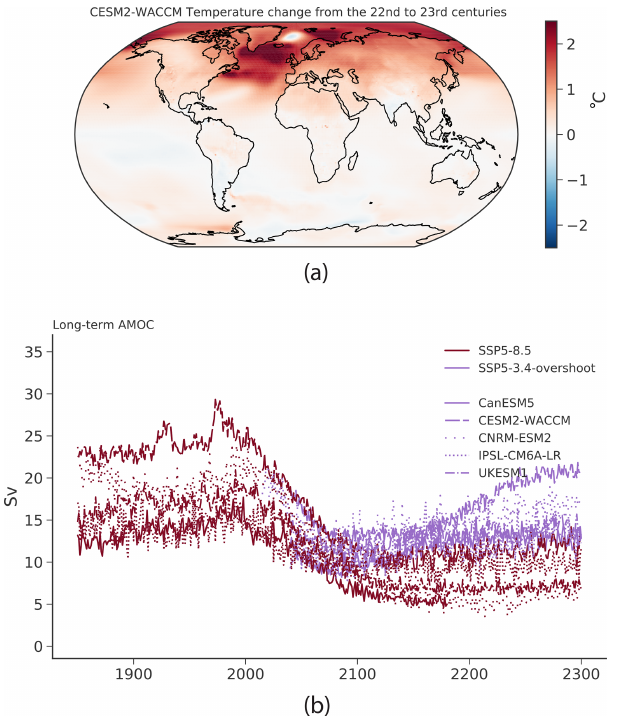
Figure 10. (a) Difference in the mean surface air temperature be- tween the 22nd and 23rd centuries in the CESM2 model under the SSP5-3.4-overshoot. (b) Strength of the Atlantic Meridional Over- turning Circulation for the all ESMs under both